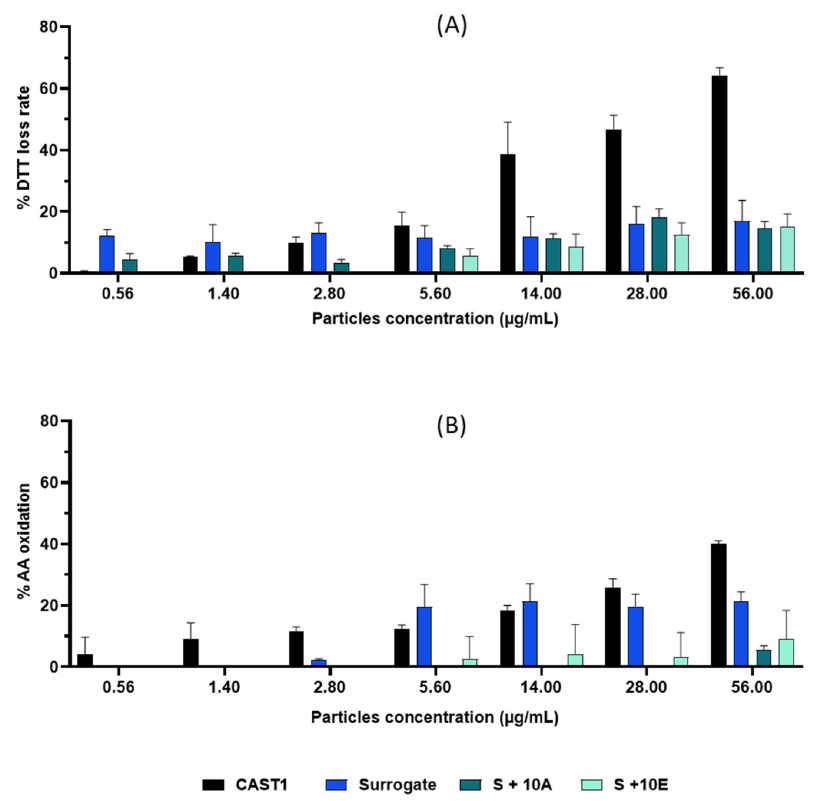
Figure 3. Oxidative potential of particles from CAST1, Surrogate, S+10A, and S+10E by DTT assay ( A ) and AA depletion measurement ( B ).